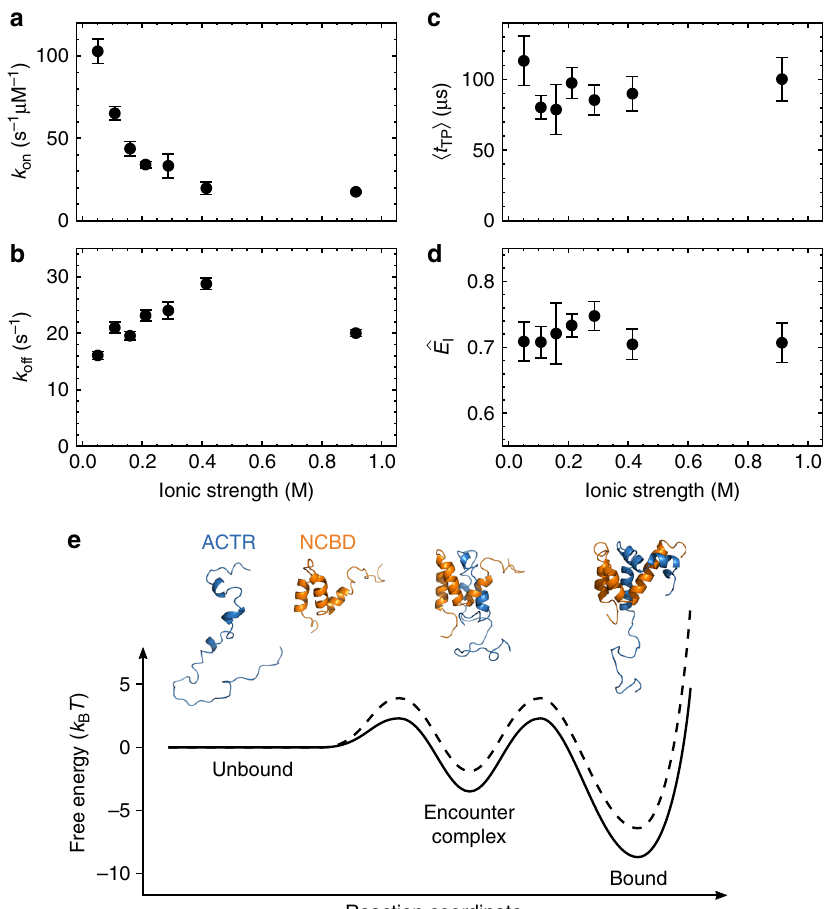
Fig. 4 Ionic-strength dependence of ACTR-NCBD binding. a Association ( k on ) and b dissociation rate coef fi cients ( k off ) as a function of ionic strength from measurements at different NaCl concentrations. Error bars indicate standard errors obtained from 100 bootstrapping trials (sample sizes are listed in Supplementary Table 1). c Average transition path time, 〈 t TP 〉 , and d transfer ef fi ciency in the encounter complex, ^ E I , as a function of ionic strength. Error bars indicate standard errors from 1000 bootstrapping trials (sample sizes are listed in Supplementary Table 3). e Schematic of the coupled folding and binding process with free-energy surfaces in the absence (solid line) and presence (dashed line) of ~0.4 M salt. Cartoon based on PDB entries 1KBH 15 and 2KKJ